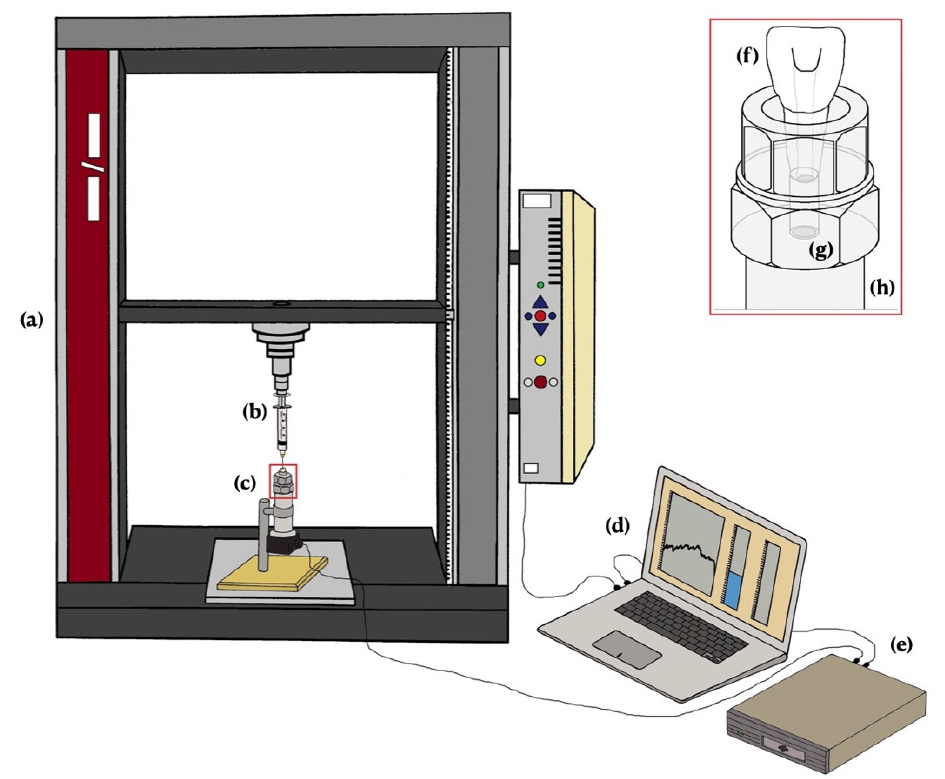
Figure 2. Experimental setup: ( a ) universal testing machine generating the force on the Scheme 30 G/25 G cannula. ( b ) Syringe filled with water and fitted with 30 G/25 G cannula. ( c ) 3D-printed central incisor on the pressure sensor. ( d ) Personal computer with laboratory software. ( e ) Analog–digital converter. ( f ) 3D-printed tooth fixed in a threaded cylinder with silicone sealant. ( g ) Pressure membrane ( h ) integrated into the pressure sensor.